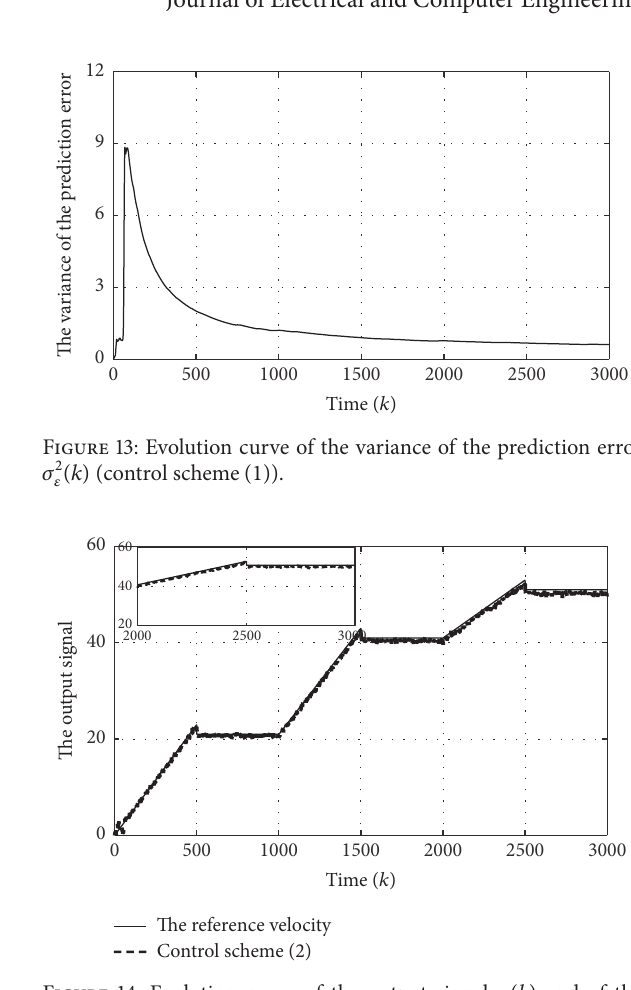
Figure 14: Evolution curve of the output signal 𝑦(𝑘) and of the reference velocity 𝑦 𝑟 (𝑘) .